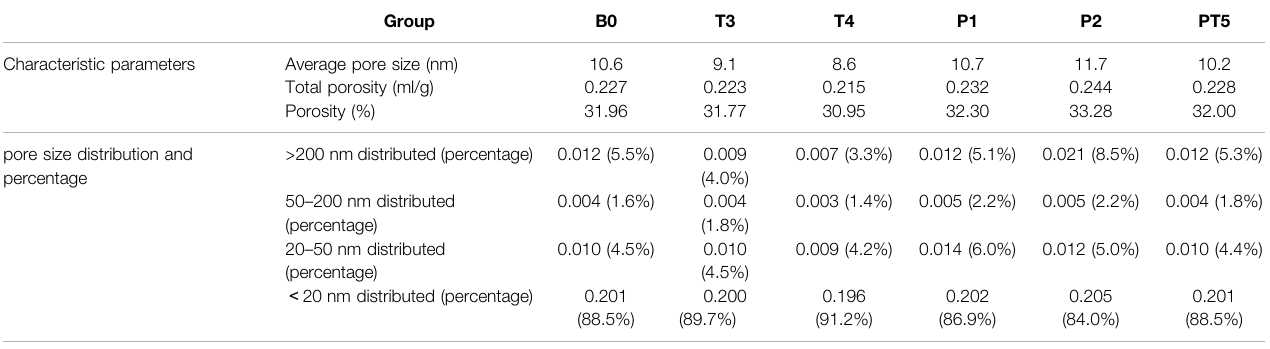
TABLE 4 | PVA fi bre and CNT-strengthened geopolymer 28-day pore size distribution, percentage (ml/g) and Characteristic parameters of the pore structure. Group